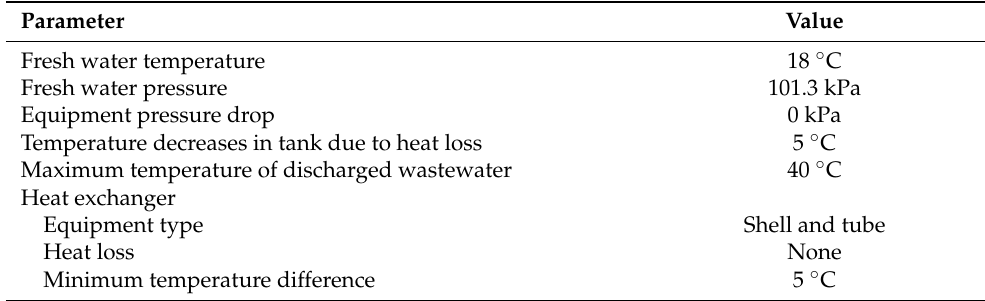
Table 2. Process design basis.